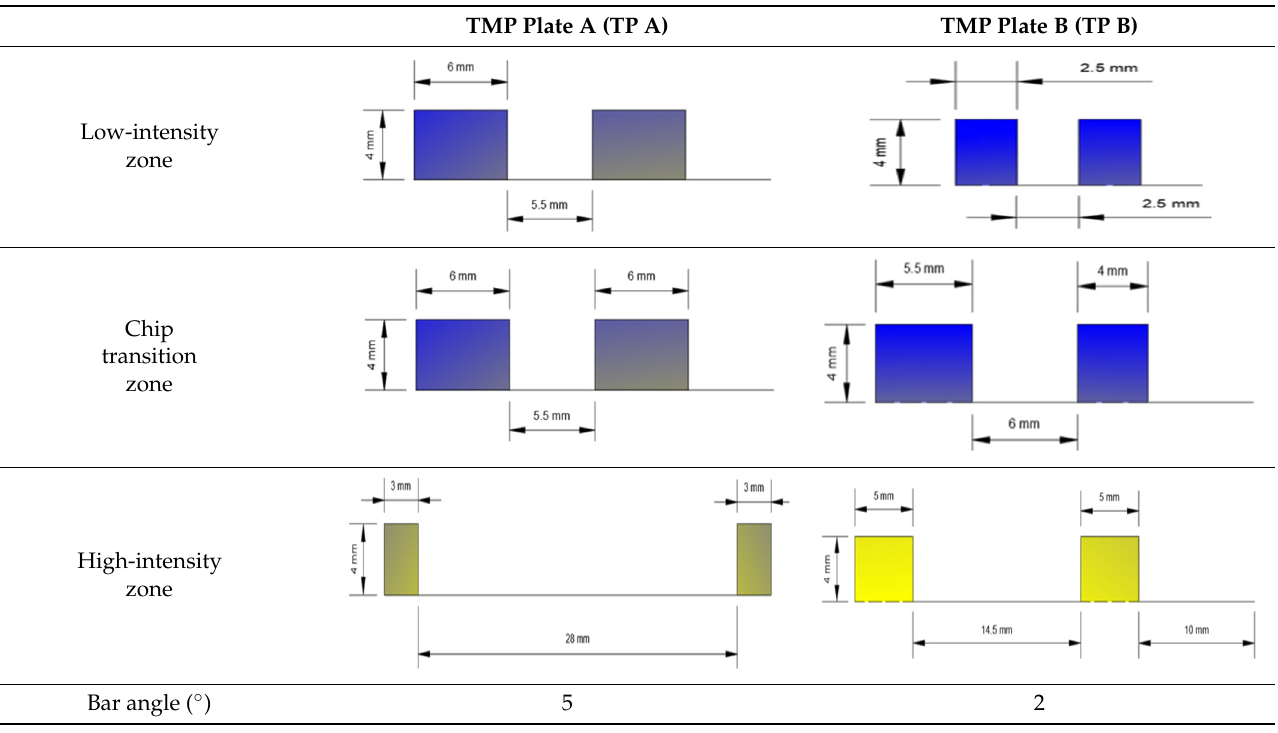
Table 4. Bar dimension in each zone of two refiner plates with different patterns.